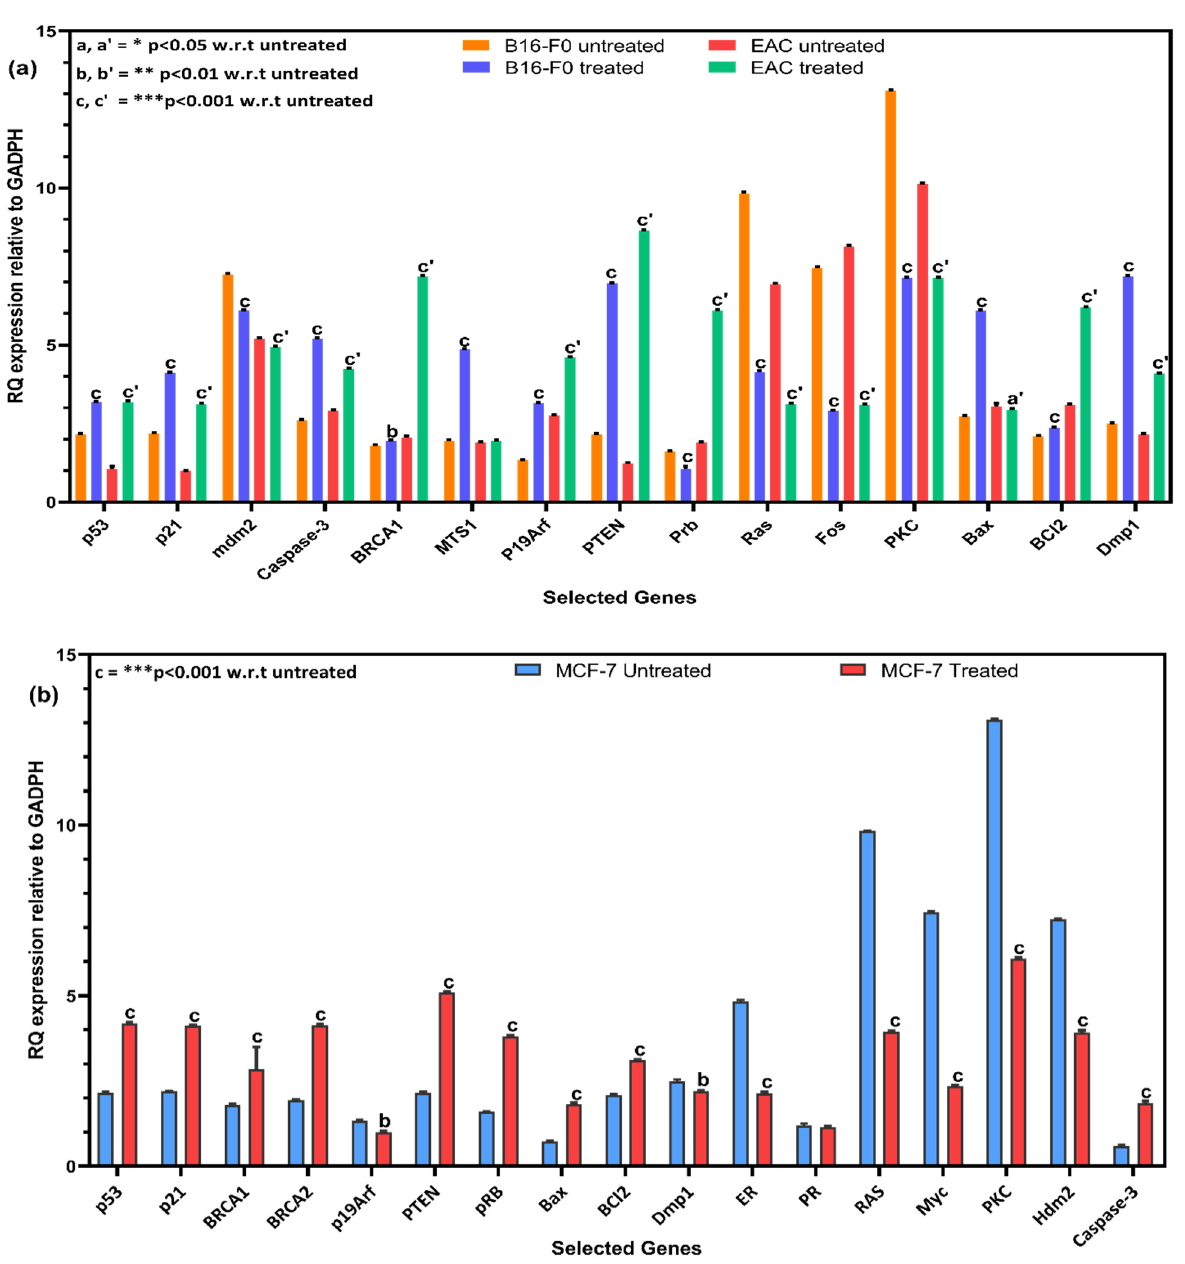
Figure 7. Effect of 4-NBTSc on gene expression ( a ) EAC and B16-F0 melanoma and ( b ) MCF-7 breast cancer.